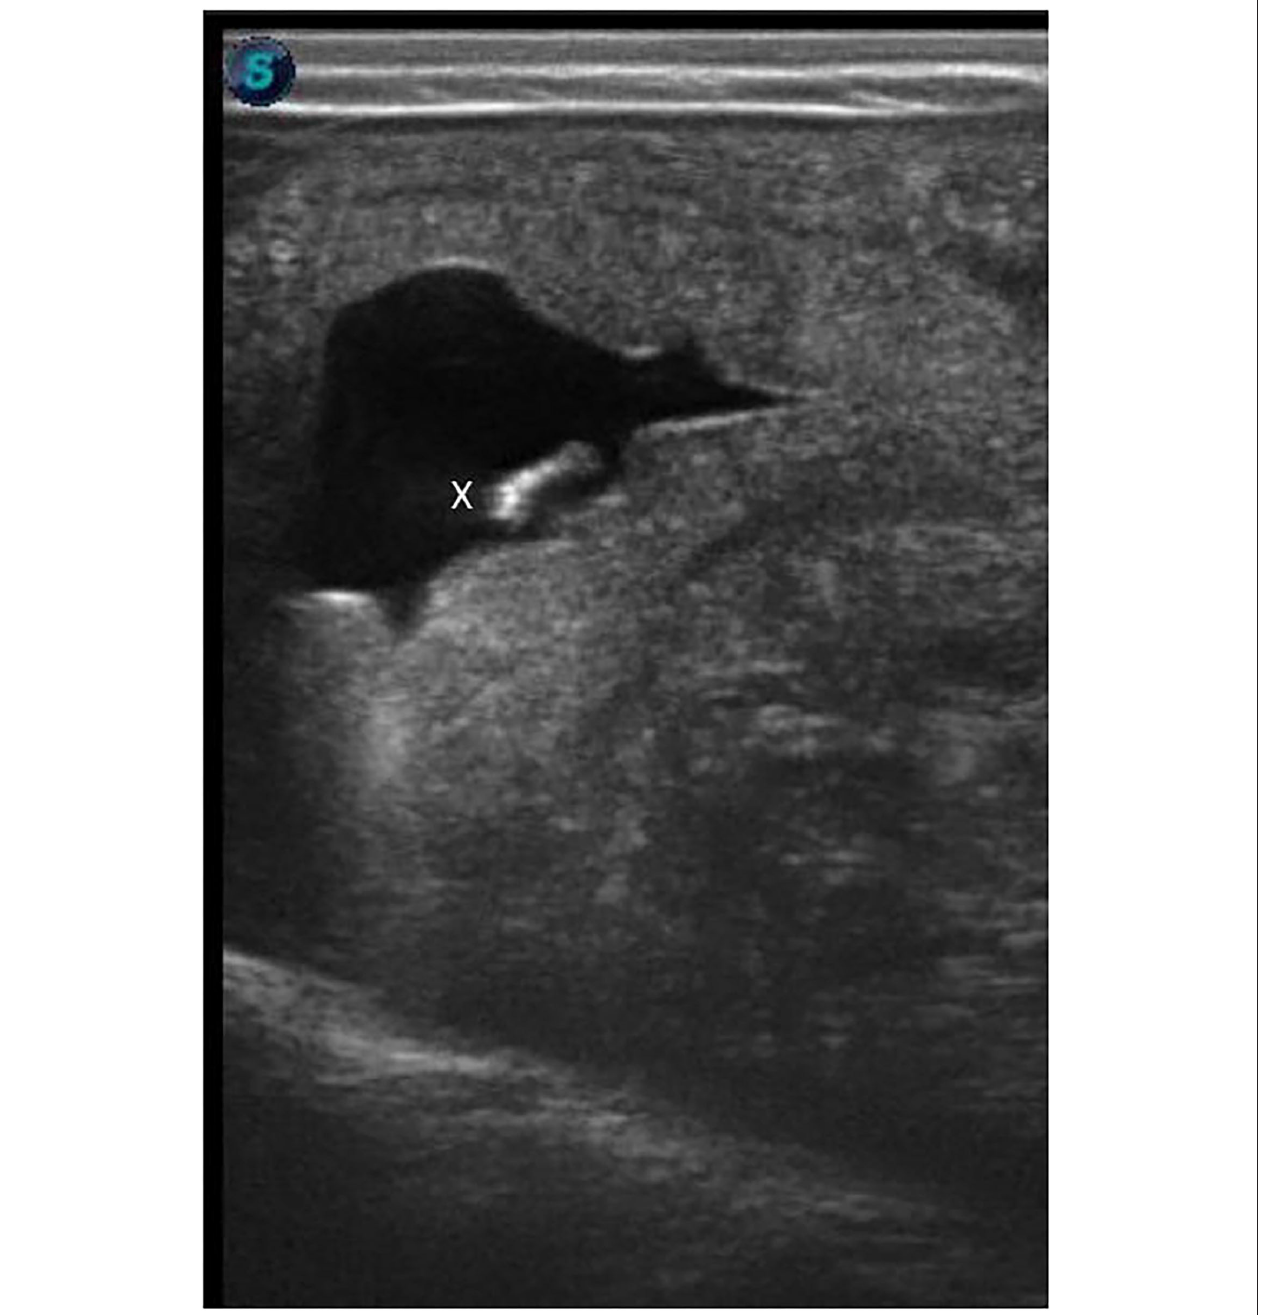
FIGURE 2 | Ultrasonographic confirmation of pregnancy after transfer of cloned blastocyst. The ultrasonographic image shows a 56-day-old fetus (x) on the uterine wall.